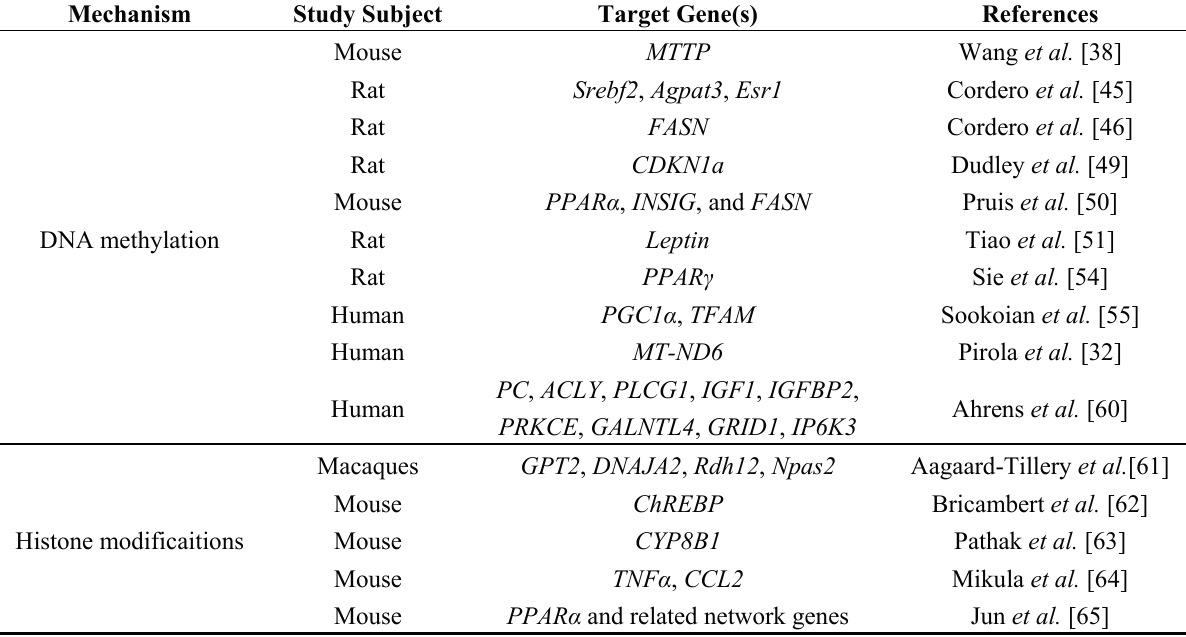
Table 1. Target genes related to DNA methylations and histone modifications in